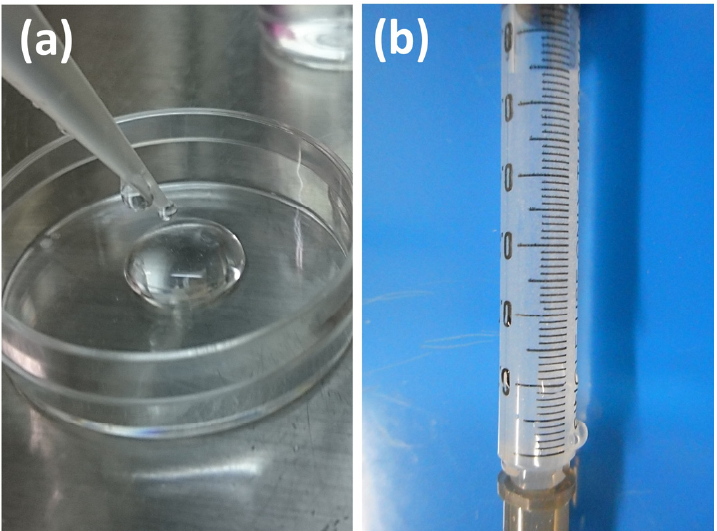
Figure 3. ( a ) SG I*nHAp ( − ) = x-tHyA + BMP in sol stage; ( b ) SG I*nHAp (+) = x-tHyA + BMP + nHAp in sol stage in a syringe.